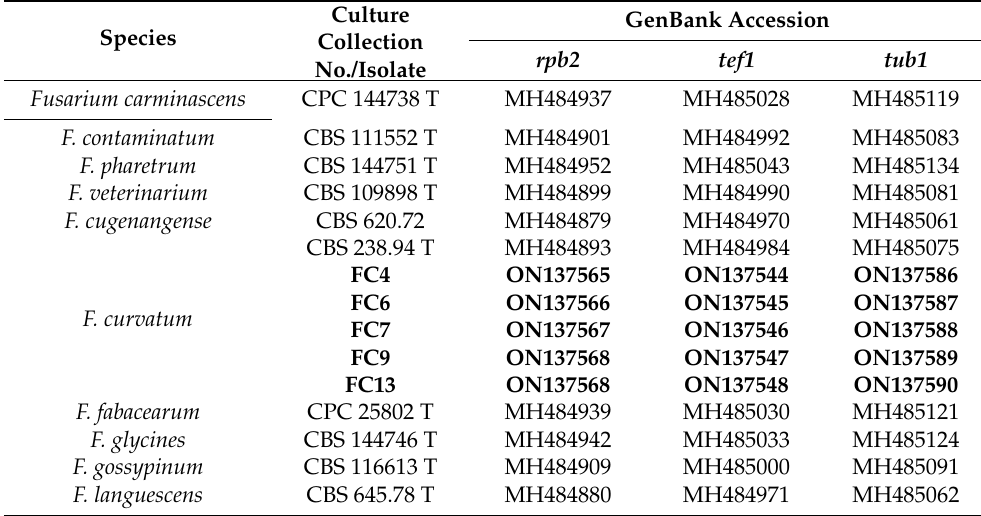
Table 1. GenBank accession numbers of Fusarium strains used in the phylogenetic